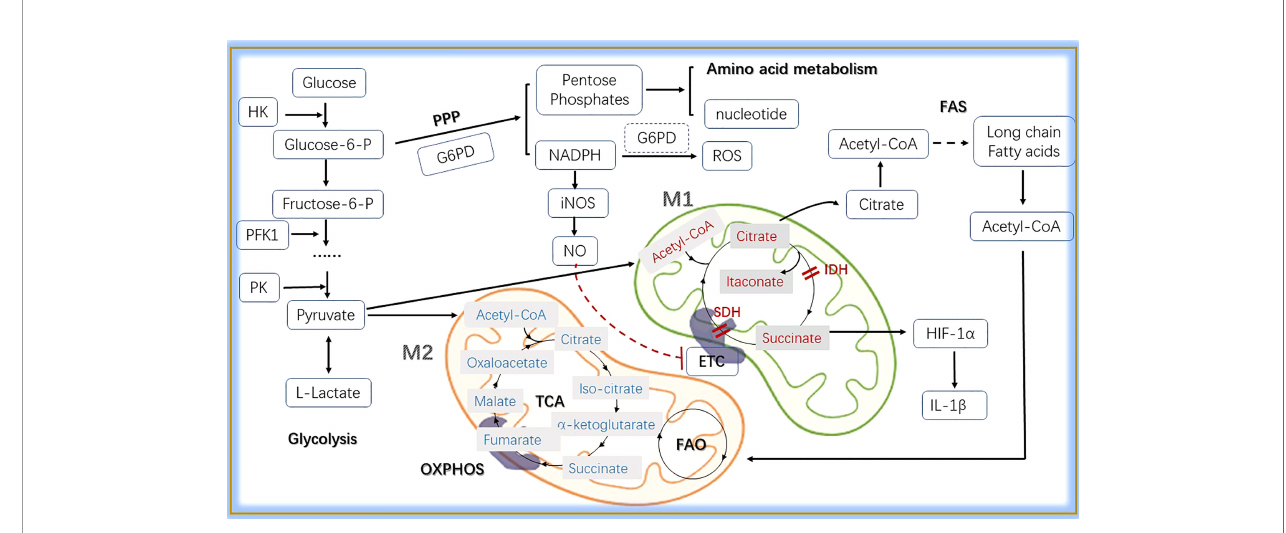
FIGURE 3 | The main metabolic pathways in macrophages. In the cytosol, glucose is converted into L-lactate by glycolysis, in which HK, PFK1 and PK are key enzymes. In the progress of glycolysis, glucose-6-P can be shunted to PPP pathway sustaining pentose phosphates and NADPH production. Pentose phosphates are used for the synthesis of amnio acid and nucleotide, while NADPH contributes to the production of ROS and NO. Pyruvate is induced to lactate in hypoxic conditions, whereas decarboxylated into acetyl-CoA within the mitochondria in normoxic conditions. Here, acetyl-CoA enters into the TCA cycle, providing reducing agents to the ETC through OXPHOS to generate energy. Citrate, a metabolite in TCA, participates in fatty acid synthesis when exported to the cytoplasm. Acetyl-CoA produced from FAS can be transferred into mitochondria and take part in the FAO. In M1 macrophages, two breakpoints cause the production of itaconate and the accumulation of succinate that induces HIF-1 a mediated upregulation of glycolysis and IL-1 b production.What ’ s more, the production of NO inhibits ETC. M2 macrophages can obtain enough ATP from OXPHOS through the TCA cycle. As for energy gain, FAO is essential. HK, hexokinase; Glucose 6-P, glucose 6-phosphate; Fructose 6-P, fructose 6-